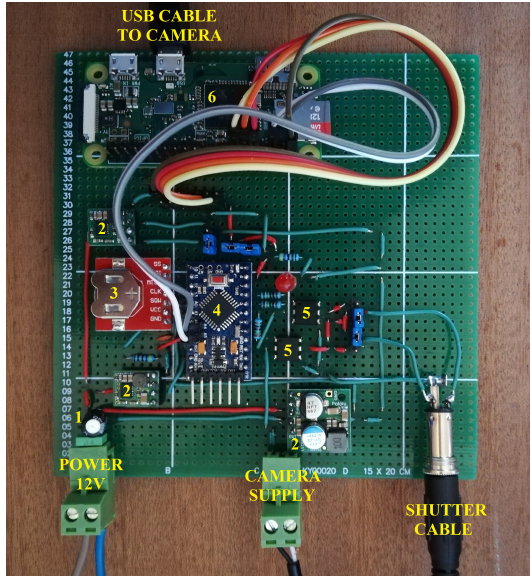
Figure 2. Stripboard on which are soldered the main components of the internal circuit: capacitors (1), voltage regulators (2), real-time clock with coin-cell battery (3), Arduino Pro Mini (4), optoisolators (5), and Raspberry Pi Zero W (6).